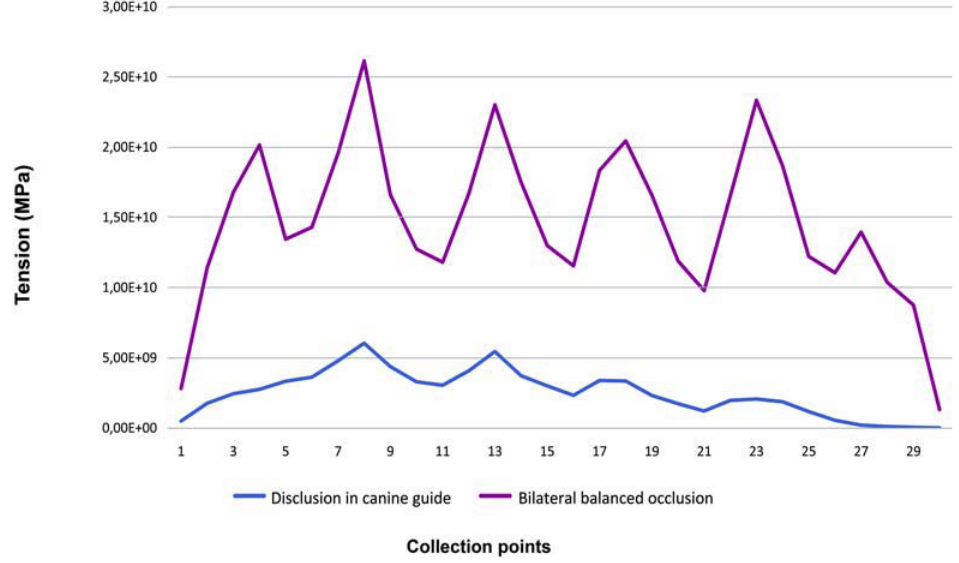
FIGURE 5- The data obtained on the collection points distributed throughout the metallic framework